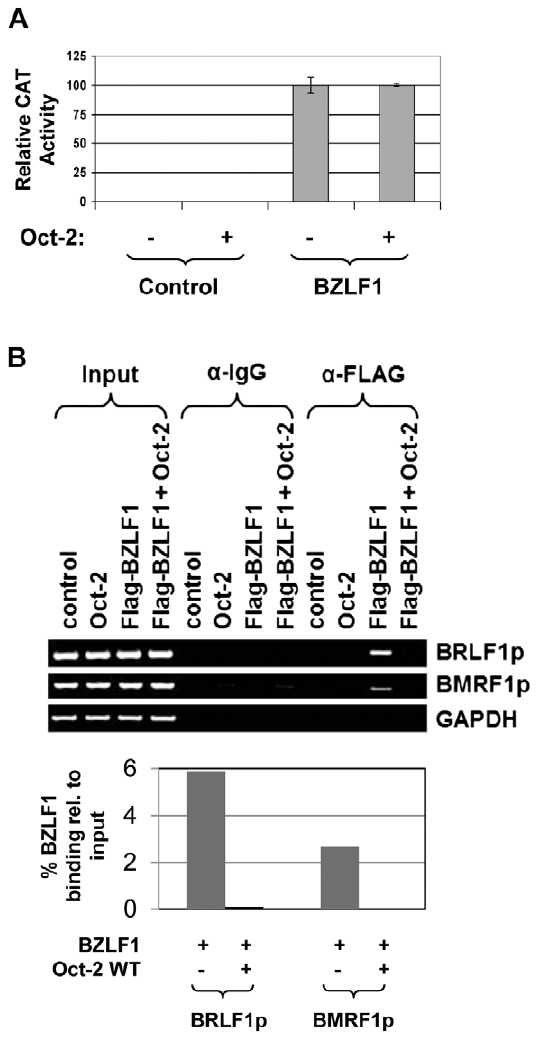
Figure 4. Oct-2 inhibits BZLF1 DNA-binding invivo . (A) HeLa cells were transfected with a Gal4-E1B-CAT construct in the presence or absence of cotransfected Gal4-BZLF1 (1–167), Oct-2, or control vectors. The relative CAT activity for each condition is shown; the value for the activity of the promoter construct plus BZLF1 is set at 100. Values are given as means 6 standard deviations of results from two independent experiments. (B) (Upper panel) A ChIP assay was performed using HONE-Akata cells transfected with Flag-tagged-BZLF1, Oct-2, or control vectors as indicated. Cross-linked DNA-protein complexes were immunoprecipitated using antibodies against Flag (BZLF1) or an IgG control. Antibody-bound DNA sequences were then PCR-amplified using primers spanning the EBV BRLF1 and BMRF1 promoters, or the GAPDH gene (negative control). (Lower panel) Binding bands were quantified using ImageJ software and represented as numerical values in bar diagrams in the lower panel. The amount of BZLF1 binding to each promoter in the presence or absence of Oct-2 was compared to input.